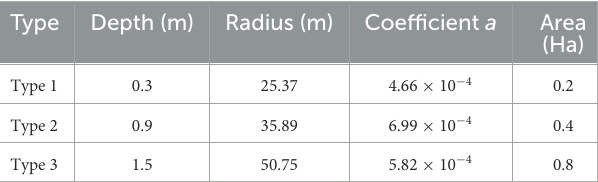
TABLE 2 Dimensions of three pothole types used in the hydrology